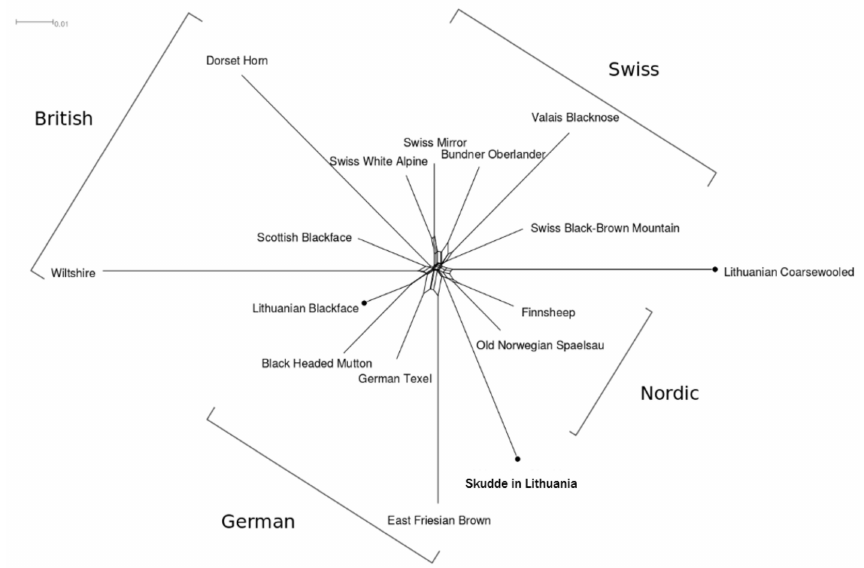
Figure 4. Neighbour-net network describing the relatedness structure among sheep breeds. The nodes for Lithuanian populations are emphasised with filled circles for